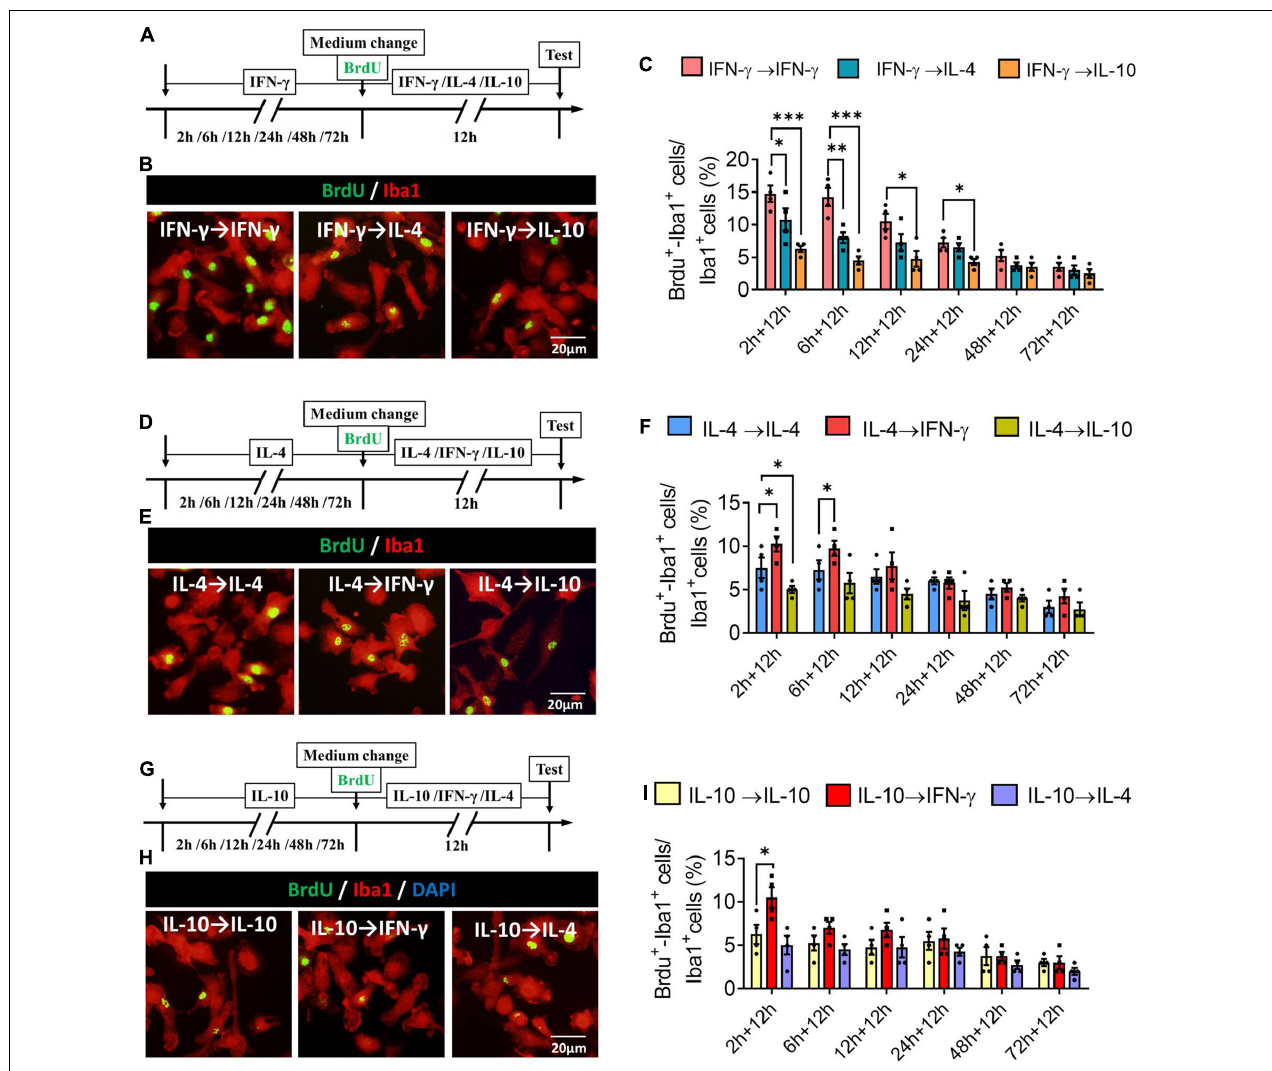
FIGURE 10 | Plasticity of proliferation ability of IFN- γ , IL- 4-, or IL-10-treated microglia in different response state. (A–C) Plasticity of proliferation ability of IFN- γ -treated microglia in different response state. (A) Experimental protocol for monitoring proliferation capacity ability after microglia initially stimulated with IFN- γ for 2–72 h, then stimulated with another cytokine for 12 h. (B) Fluorescence micrographs of primary microglial cultures after they were switched from the primary IFN- γ stimulation to secondary stimulation with IL-4 or IL-10 lasting 12 h. Cells were immunostained against Iba1 (red) and BrdU (green). (C) Percentage of proliferating microglia initially stimulated with IFN- γ , then stimulated with another cytokine. (D–F) Plasticity of proliferation ability of IL-4-treated microglia in different response state following IFN- γ or IL-10 exposure for 12 h. (G–I) Plasticity of proliferation ability of IL-10-treated microglia in different response state following IFN- γ or IL-4 exposure for 12 h. Five 40 × photographs were taken from each well, and all the cells in the field were measured. Data are presented as the mean ± SEM. n = 4–5 well per group, ∗ P < 0.05, ∗∗ P < 0.01 (one-way ANOVA with Tukey’s multiple-comparisons test).